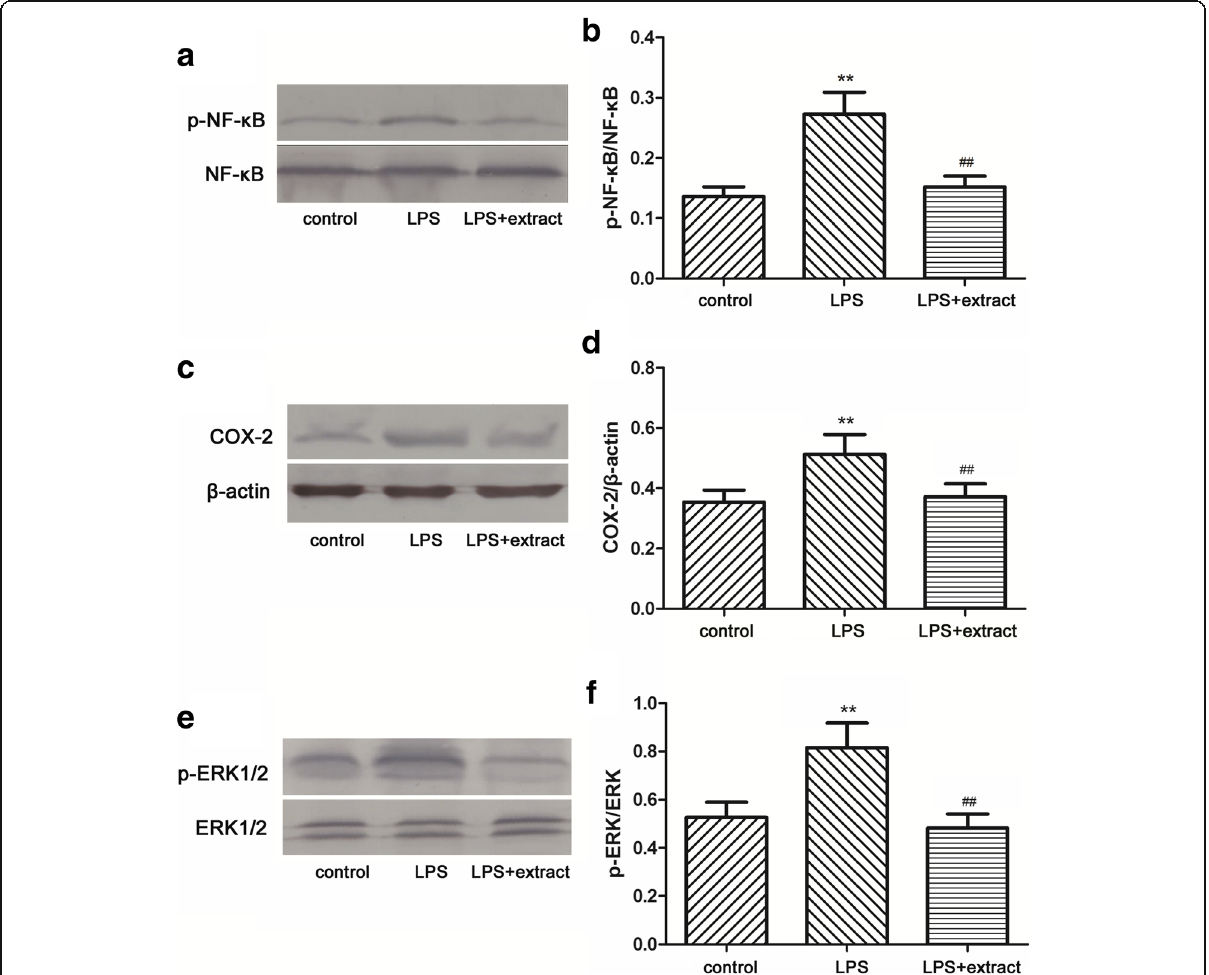
Fig. 5 p-NF- κ B, COX-2, and p-ERK1/2 protein expression in hearts. p-NF- κ B( a ), COX-2( c ), and p-ERK1/2 ( e ) protein expression in hearts was analyzed by western blot. Relative amounts of p-NF- κ B, COX-2, and p-ERK1/2 were assessed by p-NF- κ B to NF- κ B( b ), COX-2 to β -actin( d ) and p-ERK1/2 to ERK1/2 ( f ) ratio, respectively. ** p <0.01 vs. Control group; ## p <0.01 vs. LPS group ( n